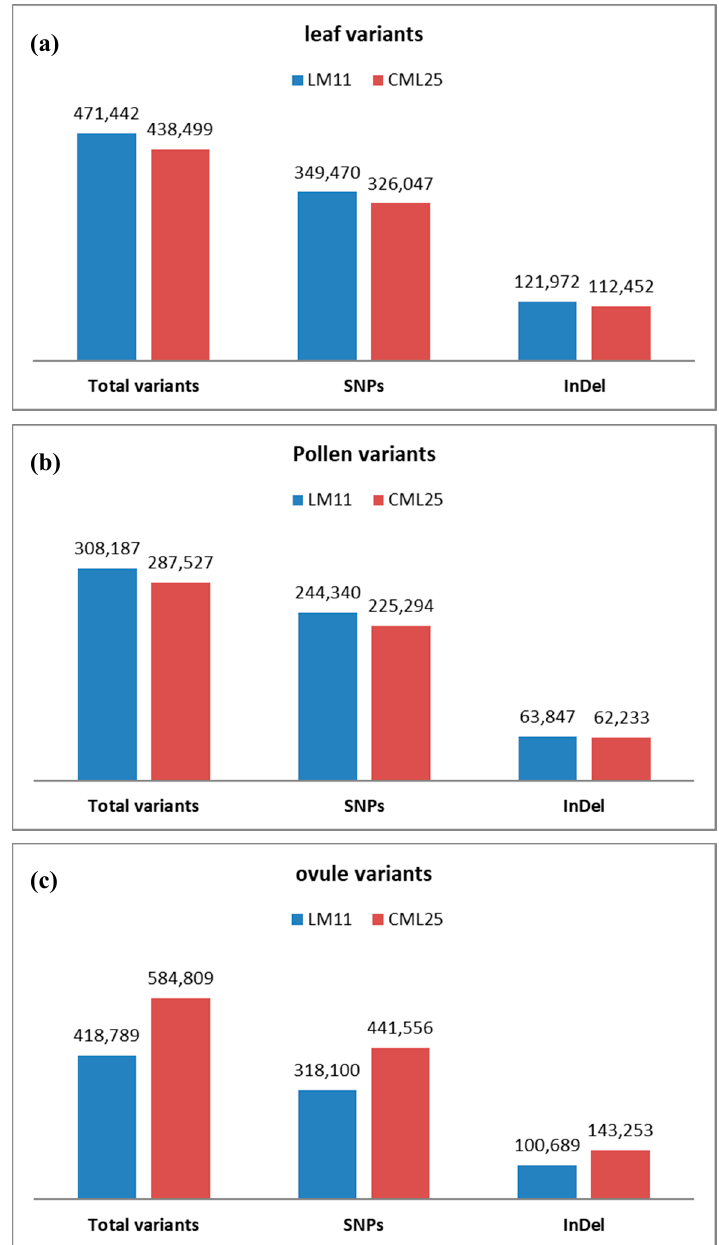
Figure 1. Variants identified in LM11 and CML25 with B73 reference mapping using Genome Analysis Toolkit (GATK) platform. ( a ) leaf variants, ( b ) pollen variants, ( c ) ovule variants.